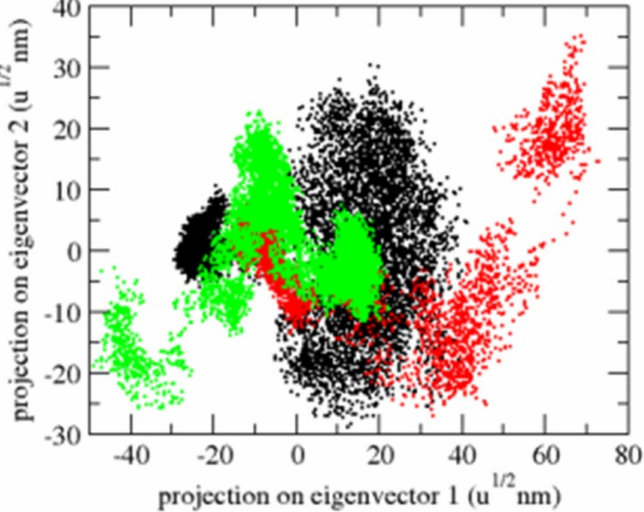
Figure 10. The 2D projection of complexes. The OmpU-control compound, OmpU-ZINC95910434, and OmpU-ZINC06494587 are shown in black, red, and green color, respectively. The Gibbs free energy landscape was also modeled, using Gromacs analysis com- mands, and utilizing projections of their respective first (PC1) and second (PC2) eigenvec- tors. The corresponding contour map of the Gibbs free energy represents less energy